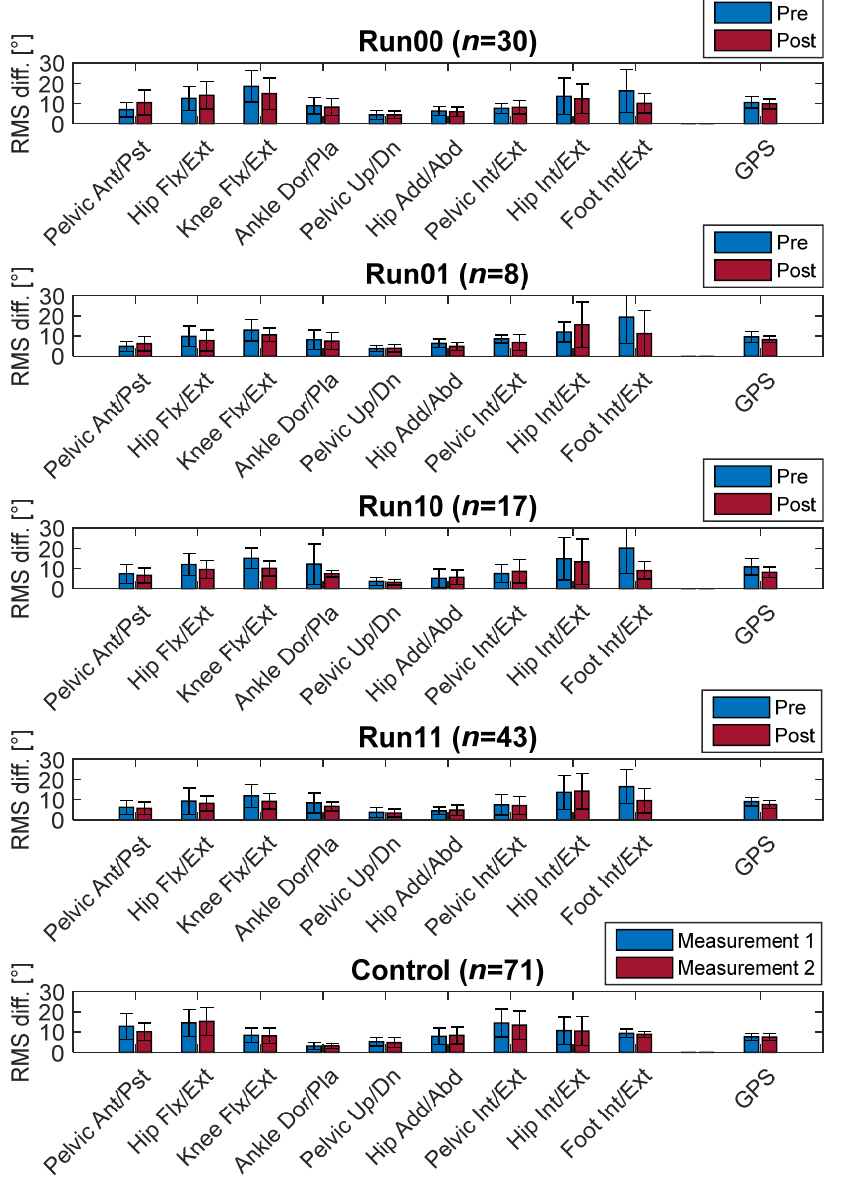
Figure 1. Movement analysis profile (MAP) and GPS changes (mean and SD). Non-runners (run00); ability gained (run01); ability lost (run10); runners (run11); RMS difference from norm (degree).